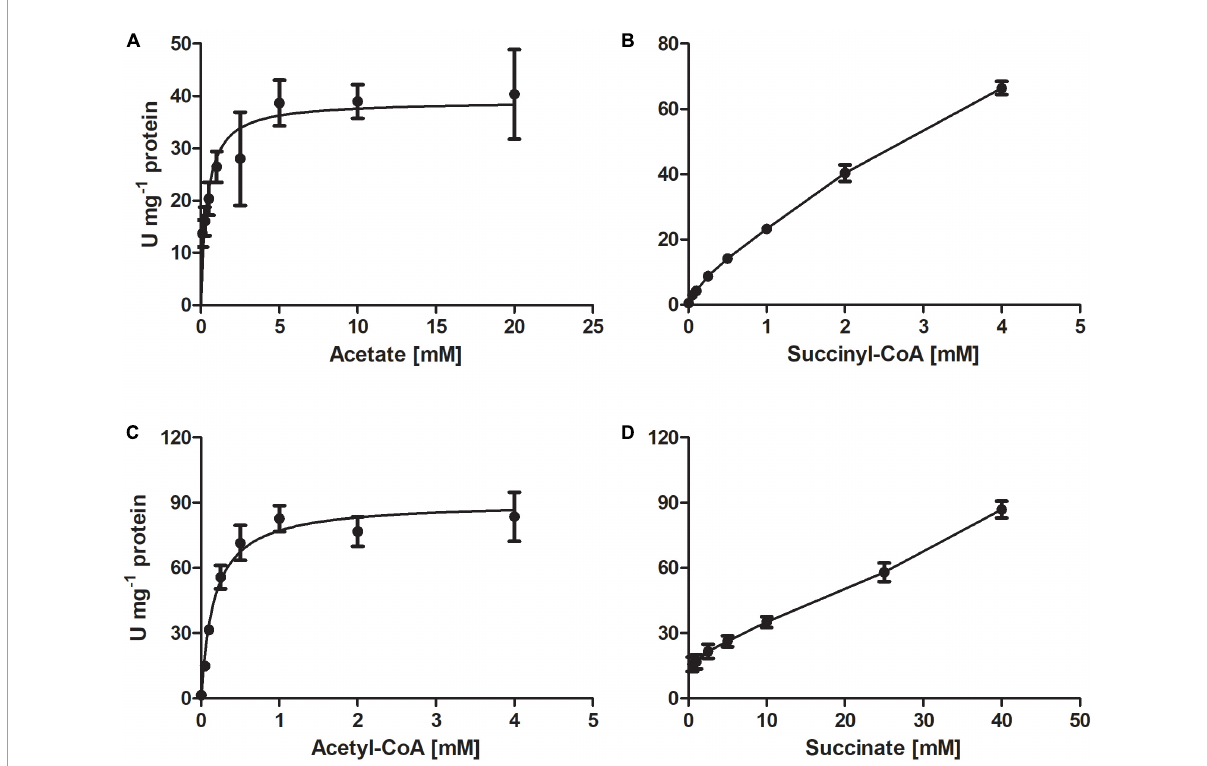
FIGURE2 Kinetics of the CoA-transferase encoded by the AHF96498 gene, measured for the acetate:succinyl-CoA (A,B) and acetyl-CoA:succinate (C,D) CoA-transferase reactions. Specific activities were measured at 55 ◦ C; data are mean ±